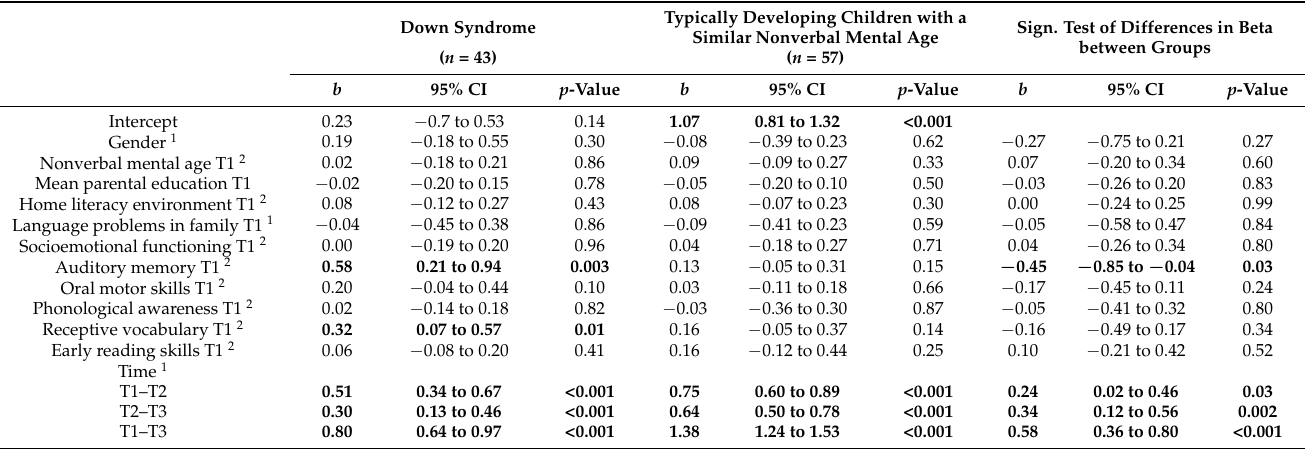
Table A1. Multivariable analysis of the predictors of expressive language over time for children with Down syndrome and typically developing children with a similar nonverbal mental age. Down Syndrome Typically Developing Children with a Similar Nonverbal Mental Age Sign. Test of Differences in Beta